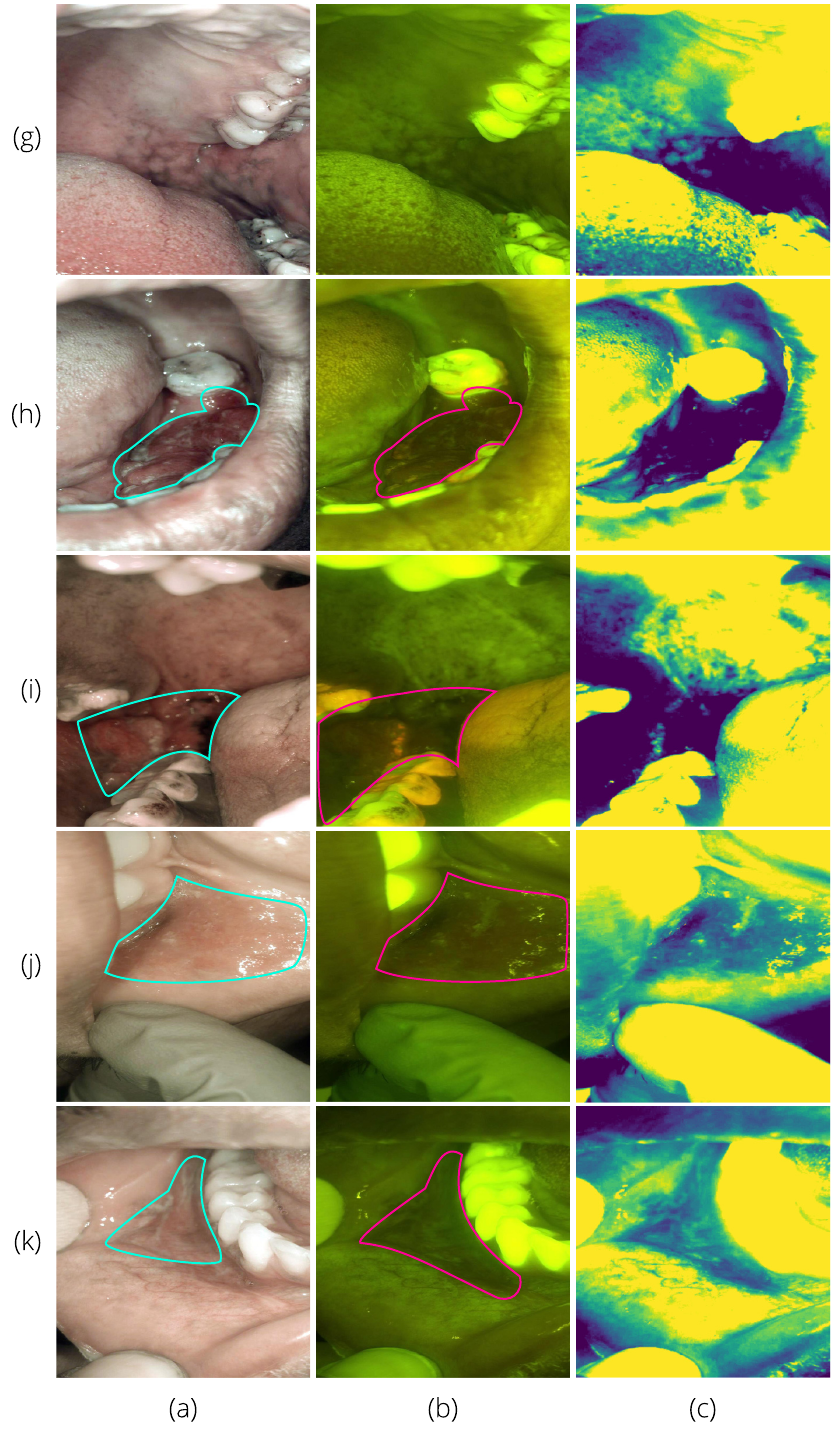
Fig 13. Sample white light (column a) and autofluorescence (column b) whole cavity module field testing images with suspect areas outlined. All rows were classified by the CNN as suspicious . On-site specialist diagnoses were: (g)— normal/variation; (h)—carcinoma of the left mandibular alveolus; (i)—oral squamous cell carcinoma; (j)—tobacco pouch keratosis; and (k)—homogeneous leukoplakia. Column (c) shows the green intensity map with the mean subtracted as discussed in Section